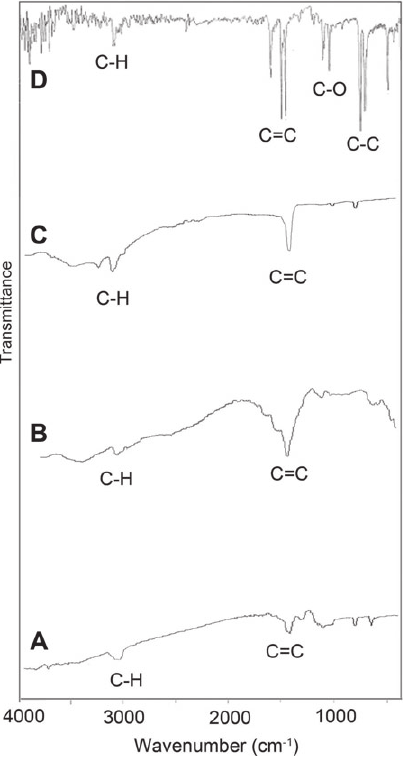
Figure 7 FT-IR spectrum of the obtained PbS with (A) 0.05, (B) 0.1, (C) 0.5 and (D) 1 m of